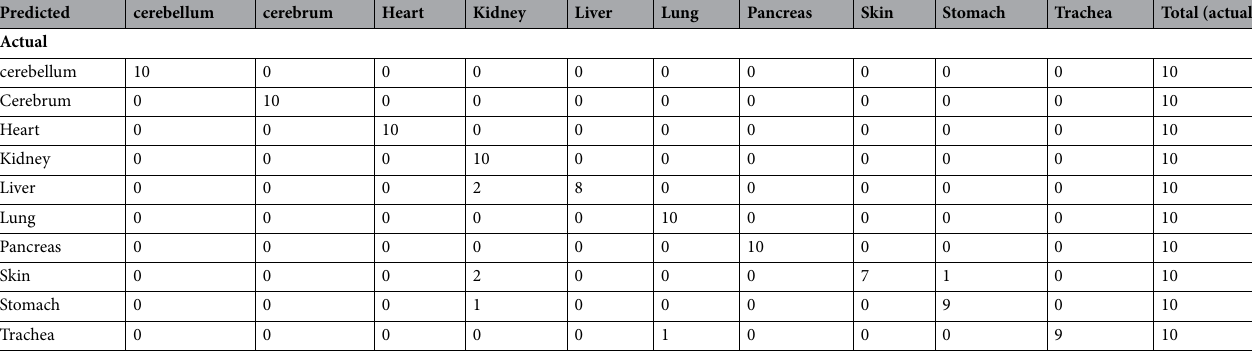
Table 7. Confusion matrix of the IML model on the quiz questionnaire (n = 100); as in the validation set, the commonest errors were met in recognising skin (03 errors).